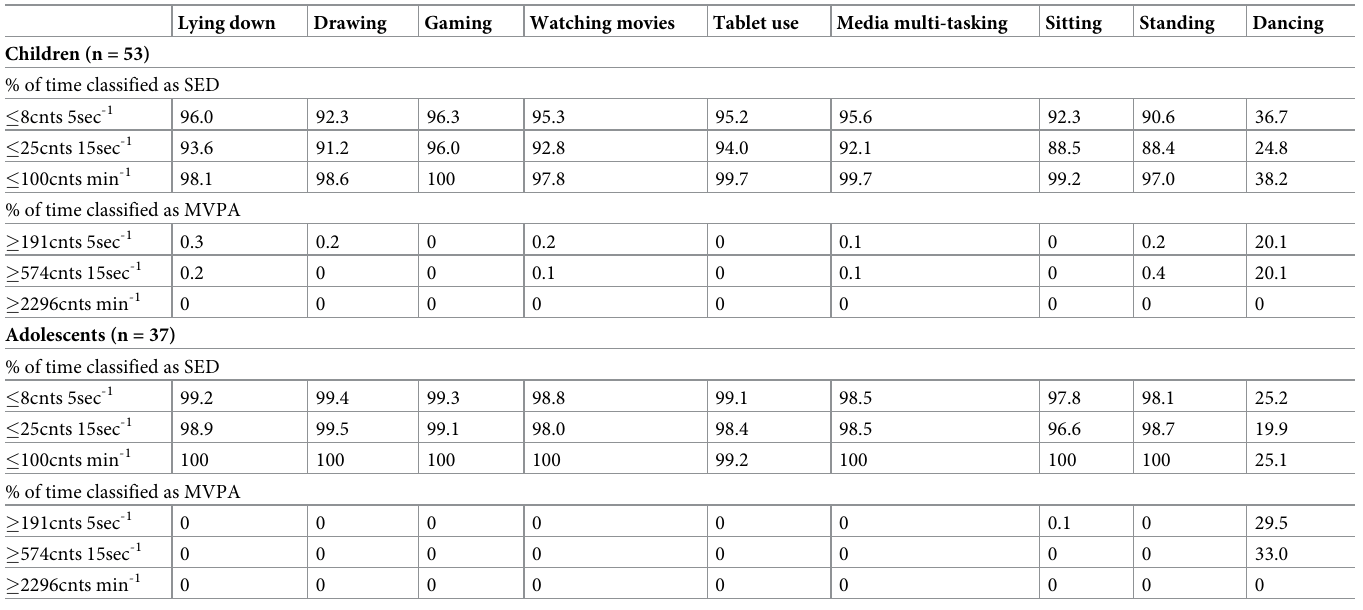
Table 2. Percentage of time classified as sedentary behaviour and MVPA for the different activities, using different epoch lengths. Lying down Drawing Gaming Watching